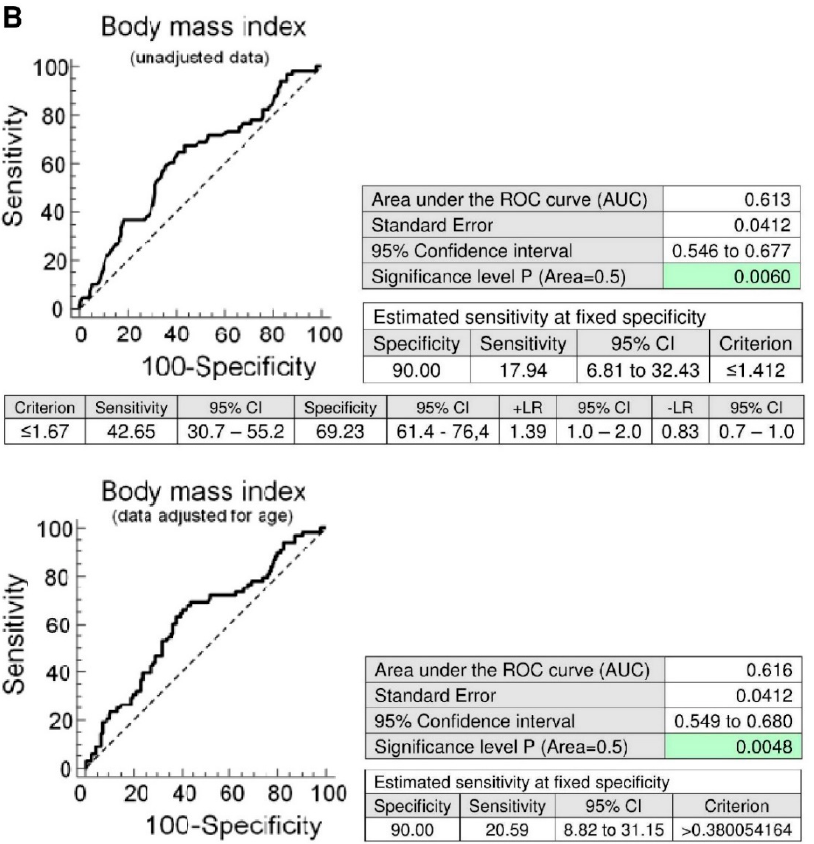
Figure 2. Association between the occurrence of vascular endothelial dysfunction and overweight. ( A ) Overweight women (BMI ≥ 25– < 30) showed significantly decreased RHI levels when compared with the group of women with normal values of BMI ( BMI < 25) (unadjusted data: p = 0.036, data adjusted for the age of women: p = 0.039). ( B ) At 10.0% FPR, a markedly higher proportion of overweight women had RHI values below cut-o ff values. 17.94% young women before adjustment of the data for the age had RHI values ≤ 1.412. In parallel, 20.59% women after adjustment of the data for the age had significantly lower RHI